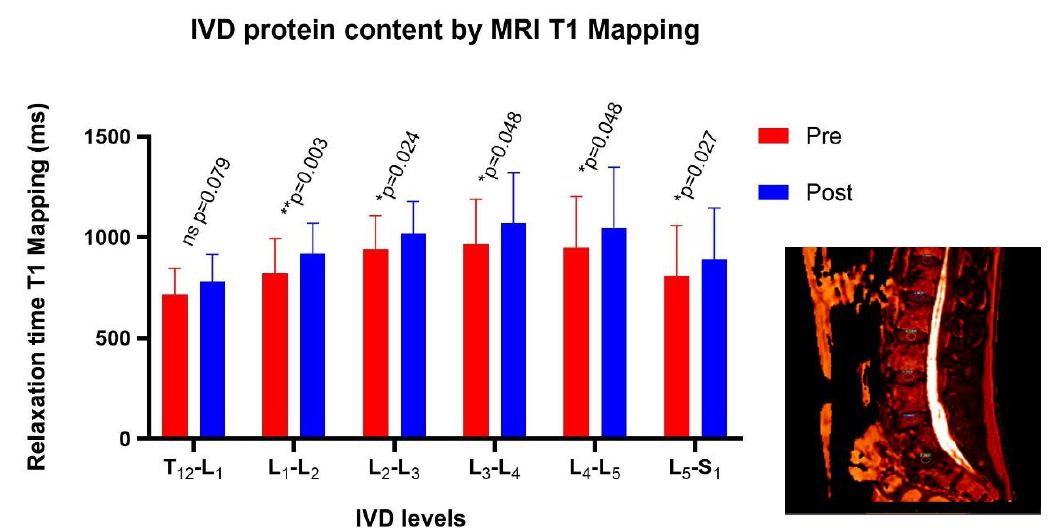
Figure 5. T1 mapping images pre vs. post are presented with an OleaSphere filter with the region of interest (ROI) inside the nucleus pulposus (NP). Protein content in the NP significantly increased after DI (* p < 0.05 and ** p < 0.01).